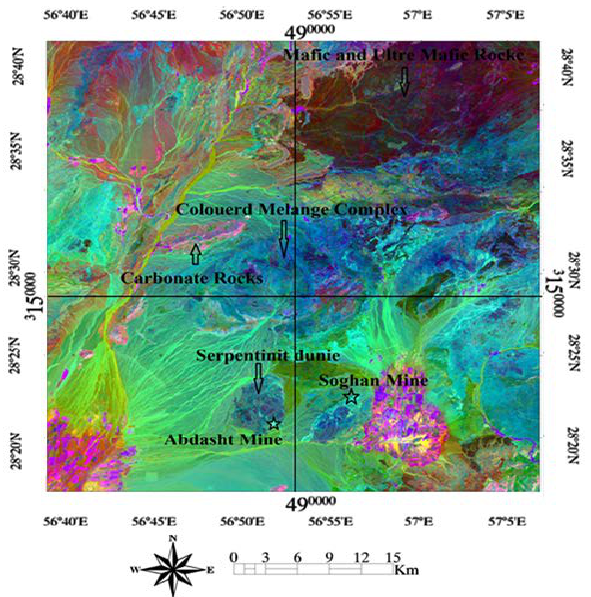
Figure 4. RGB color composites of MNF eigenimages 1, 2, and 3 extracted from Landsat TM data.